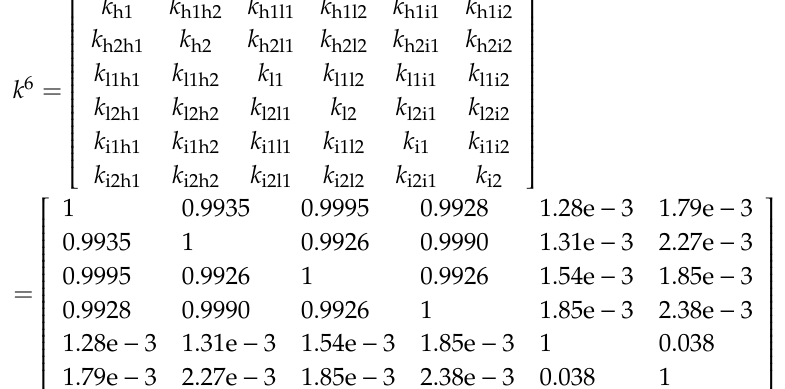
Table 3. Parameters of the HSTT and converter system.